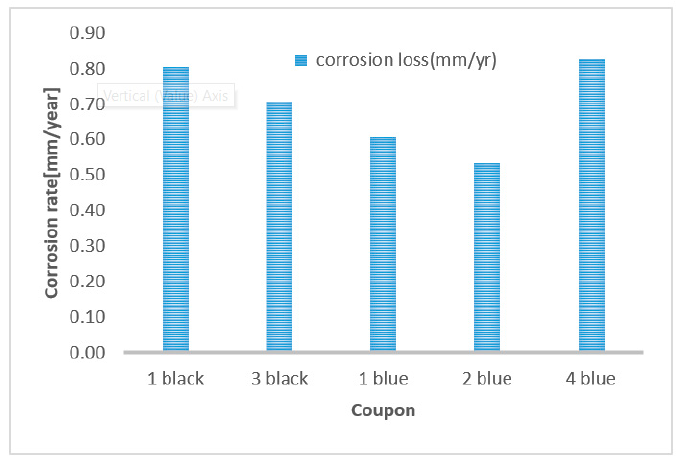
Figure 11. Variation of corrosion as a function of colour coded plate.